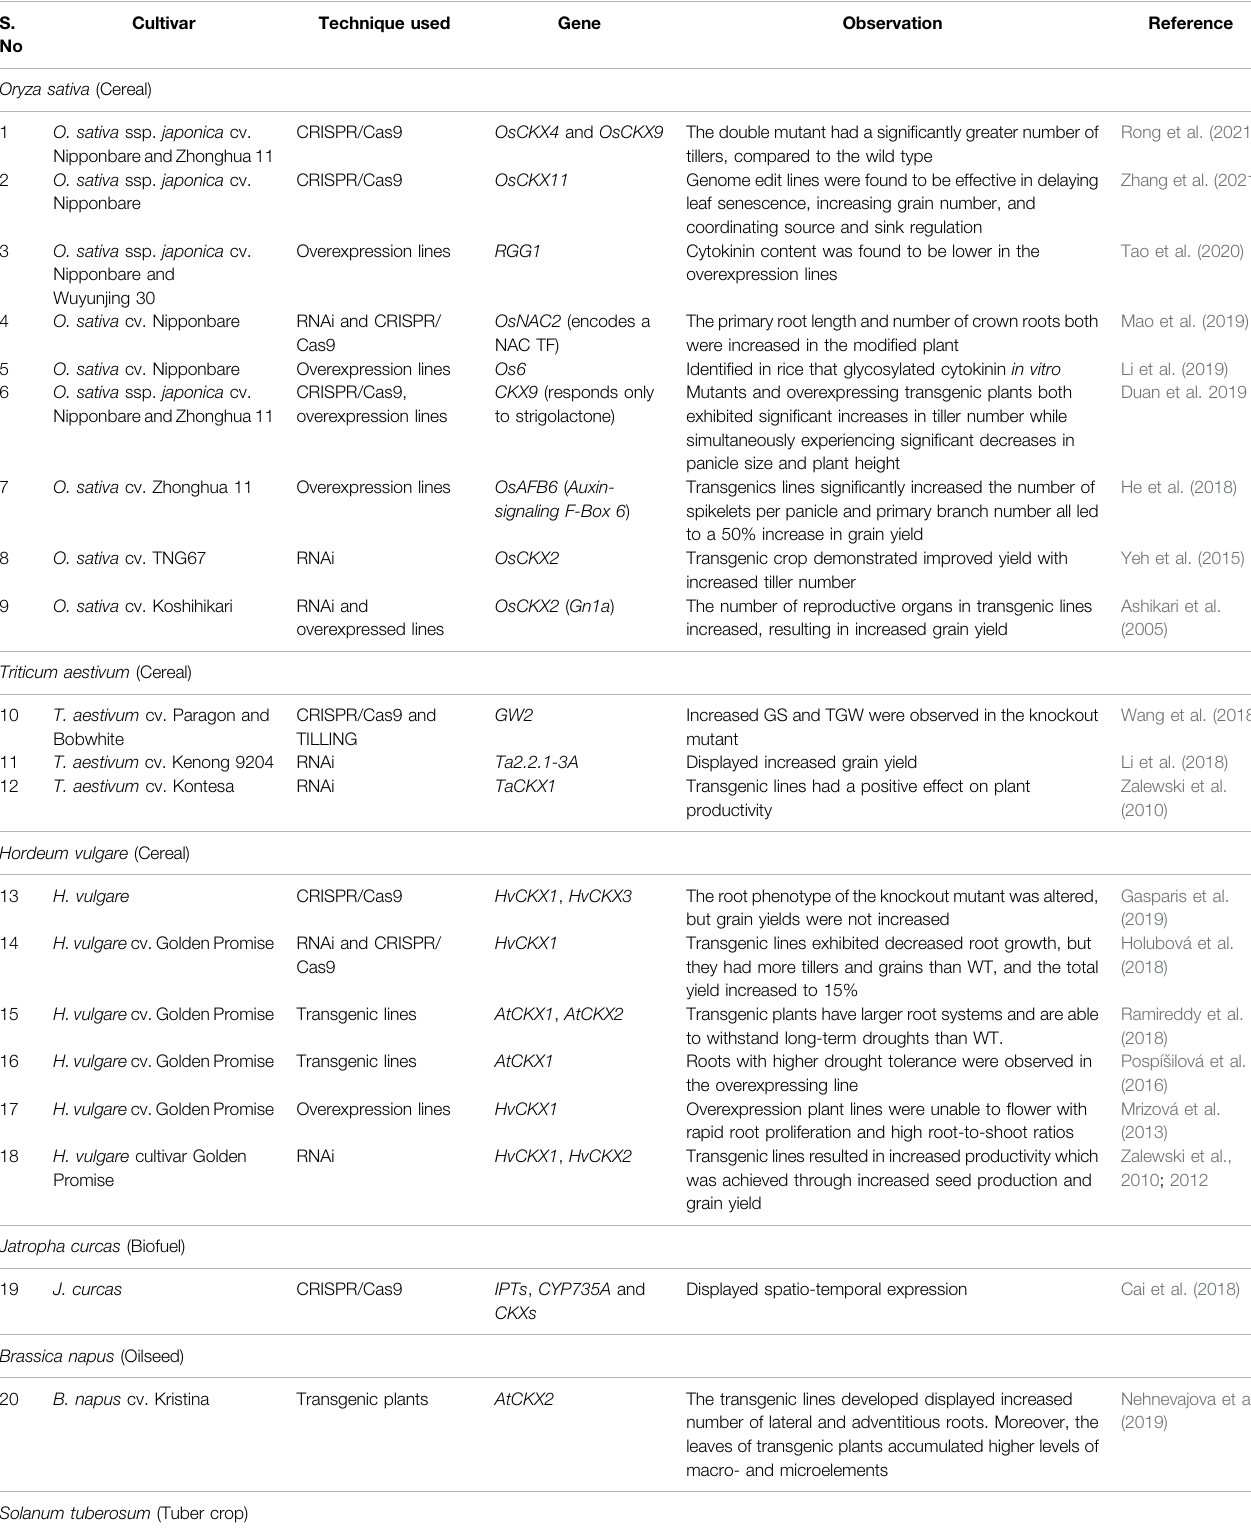
TABLE 1 | Summary of cytokinin oxidase/dehydrogenase (CKX) expression/activity on yield attributes in agronomically important